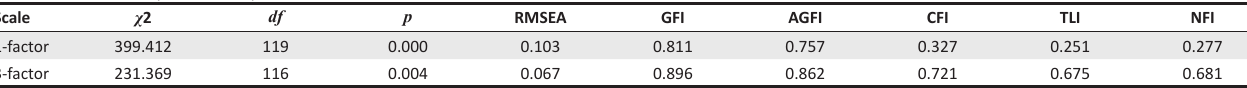
TABLE 2: Confirmatory factor analysis